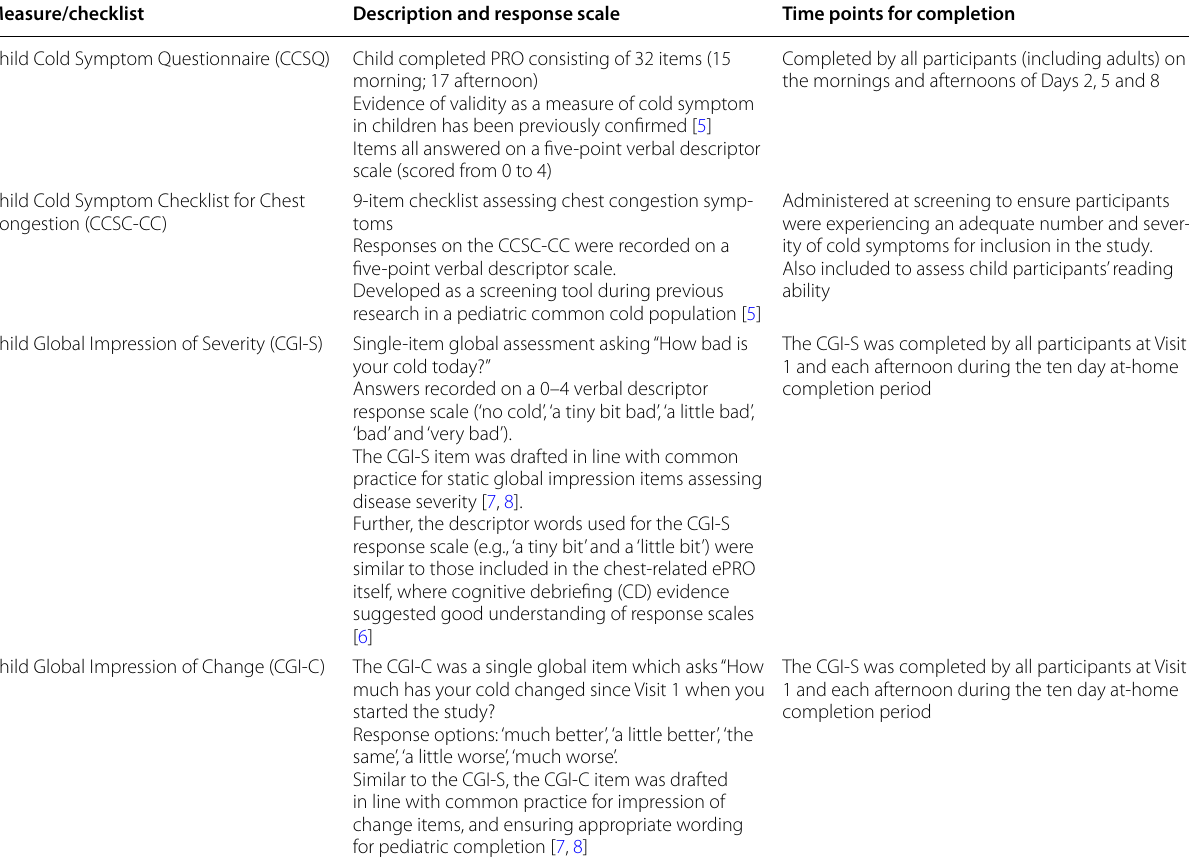
Table 1 PRO measures and checklists administered during the study to aid validation of the chest-related ePRO